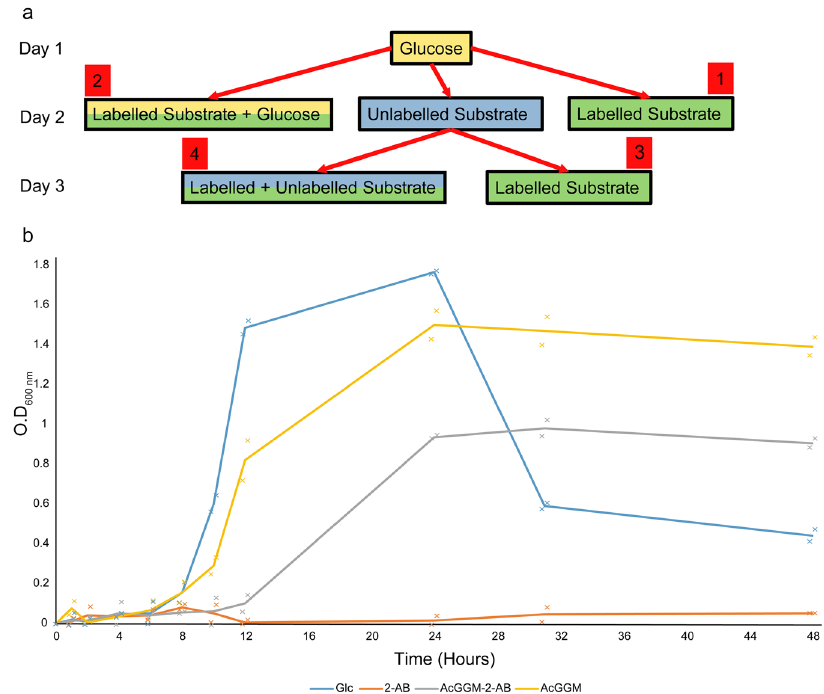
Fig. 3 Plan implemented to determine the most ef fi cient method of identifying labelled glycan uptake and bacterial growth curves for B. cellulosilyticus . a Condition set 1 added to overnight glucose-grown culture, 2 introduced as a mixture of glucose and labelled substrate to overnight glucose-grown culture, 3 overnight glucose-grown culture supplemented with unlabelled substrate, followed by next day addition of either labelled substrate or 4 a mix of labelled and unlabelled substrates. Glucose (yellow), unlabelled (blue), labelled (green). b B. cellulosilyticus grown on glucose (blue), 2-AB (orange), 2-AB-labelled AcGGM (grey), and AcGGM (yellow) (data based on 2 biological replicates).